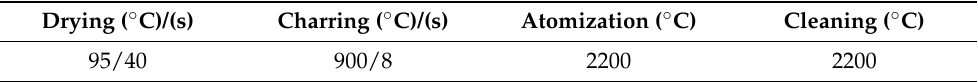
Table 4. The metrological parameters of magnesium quantitation in the experimental